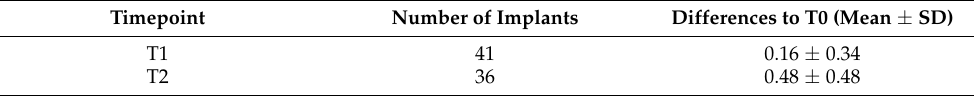
Table 3. Marginal bone loss.